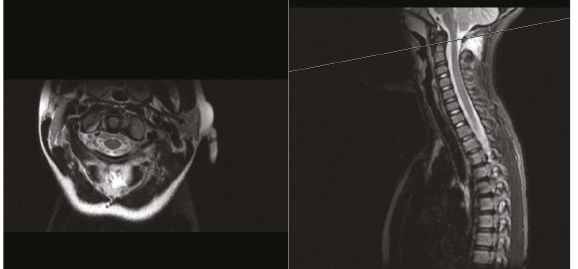
Figure 3: MRI scan of C-spine T1.